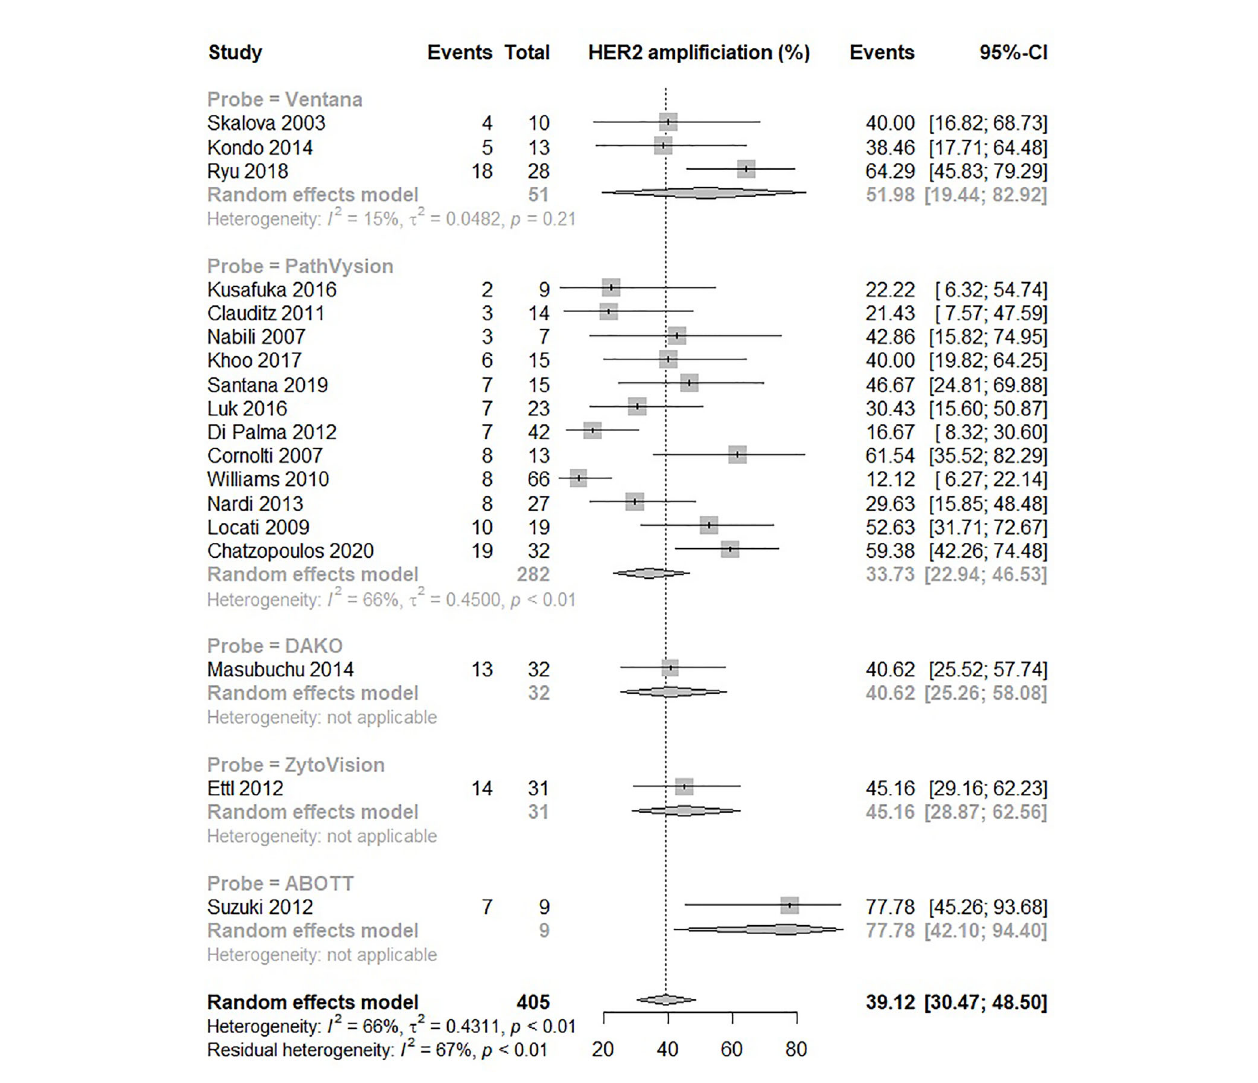
FIGURE 3 | Forrest plot of HER2 gene ampli fi cation rate in SDC assessed by in situ